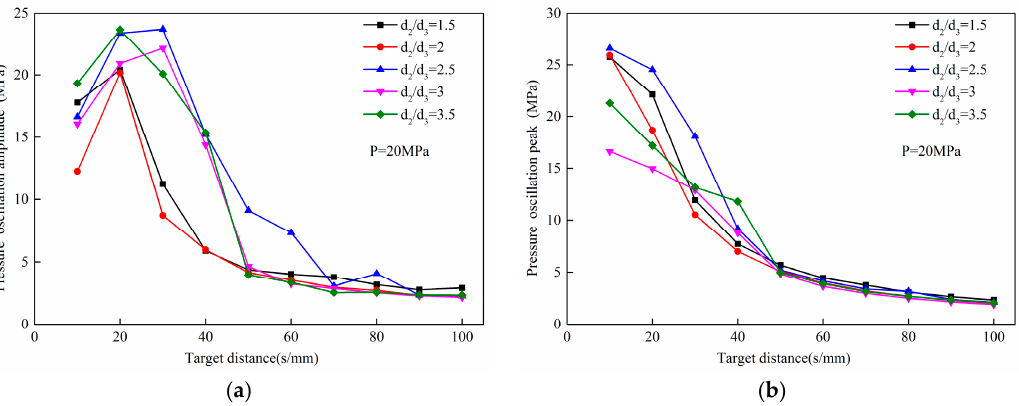
Figure 10. Effect of d 2 / d 3 on nozzle performance at 20 MPa pressure. ( a ). curves of nozzles with different d 2 / d 3 on pressure pulsation amplitude at different target distances. ( b ). curves of nozzles with different d 2 /d 3 on pressure oscillation peak at different target distances.